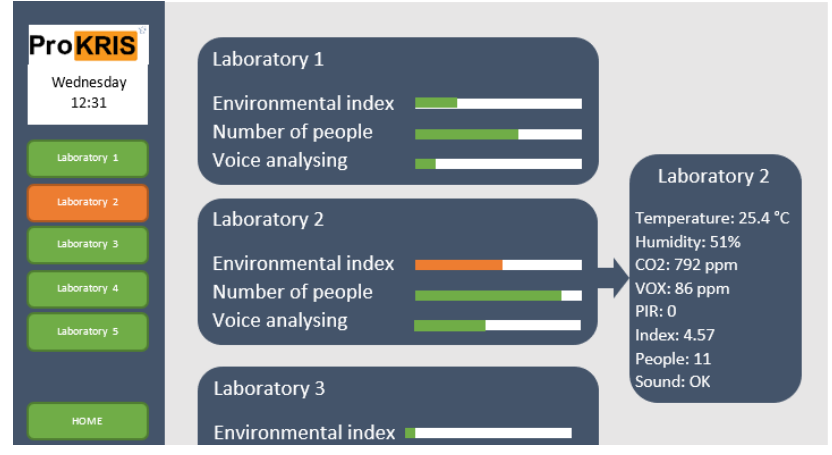
Figure 7. Concept of system.